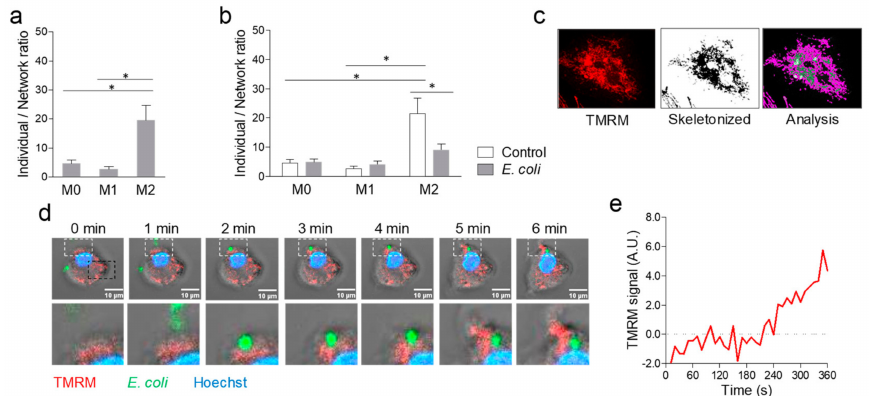
Figure 3. Mitochondrial remodelling during phagocytosis. Using the mitochondrial network analysis (MiNA) tool on macrophages stained with TOMM20, we calculated the ratio between individual macrophages and a macrophage network. ( a ) Average individual / network ratio in resting (M0), M1-, and M2-polarized macrophages (* p < 0.05 after ANOVA). ( b ) Average individual / network ratio in resting (M0), M1-, and M2-polarized macrophages before and after challenge with E. coli fragments (* p < 0.05 after 2-way ANOVA). ( c ) Representative images of a region of interest (ROI, ~40 µ ) set around one macrophage to show the pattern of TOMM20 staining, result of the skeletonization procedure after imaging processing, and the analysis with MiNA tool. ( d ) Time-series obtained during live recording, cropped around a single M2 macrophage ROI (~40 µ ), to show internalization of an E. coli fragment. Macrophages were stained with Hoechst 33342 and TMRM. The lower lane of images represents magnifications of the white, dashed insert of images in the upper lane. ( e ) TMRM fluorescence intensity over time in the white, dashed insert, where E. coli fragment internalization occurred, after subtraction of the TMRM fluorescence intensity in an equal remote ROI (black, dashed